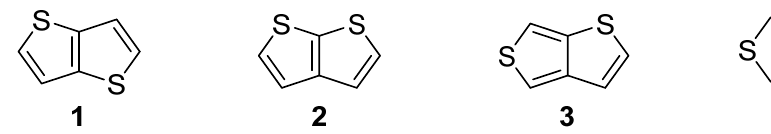
Figure 1. Molecular structure of four possible TT isomers 1 – 4 .